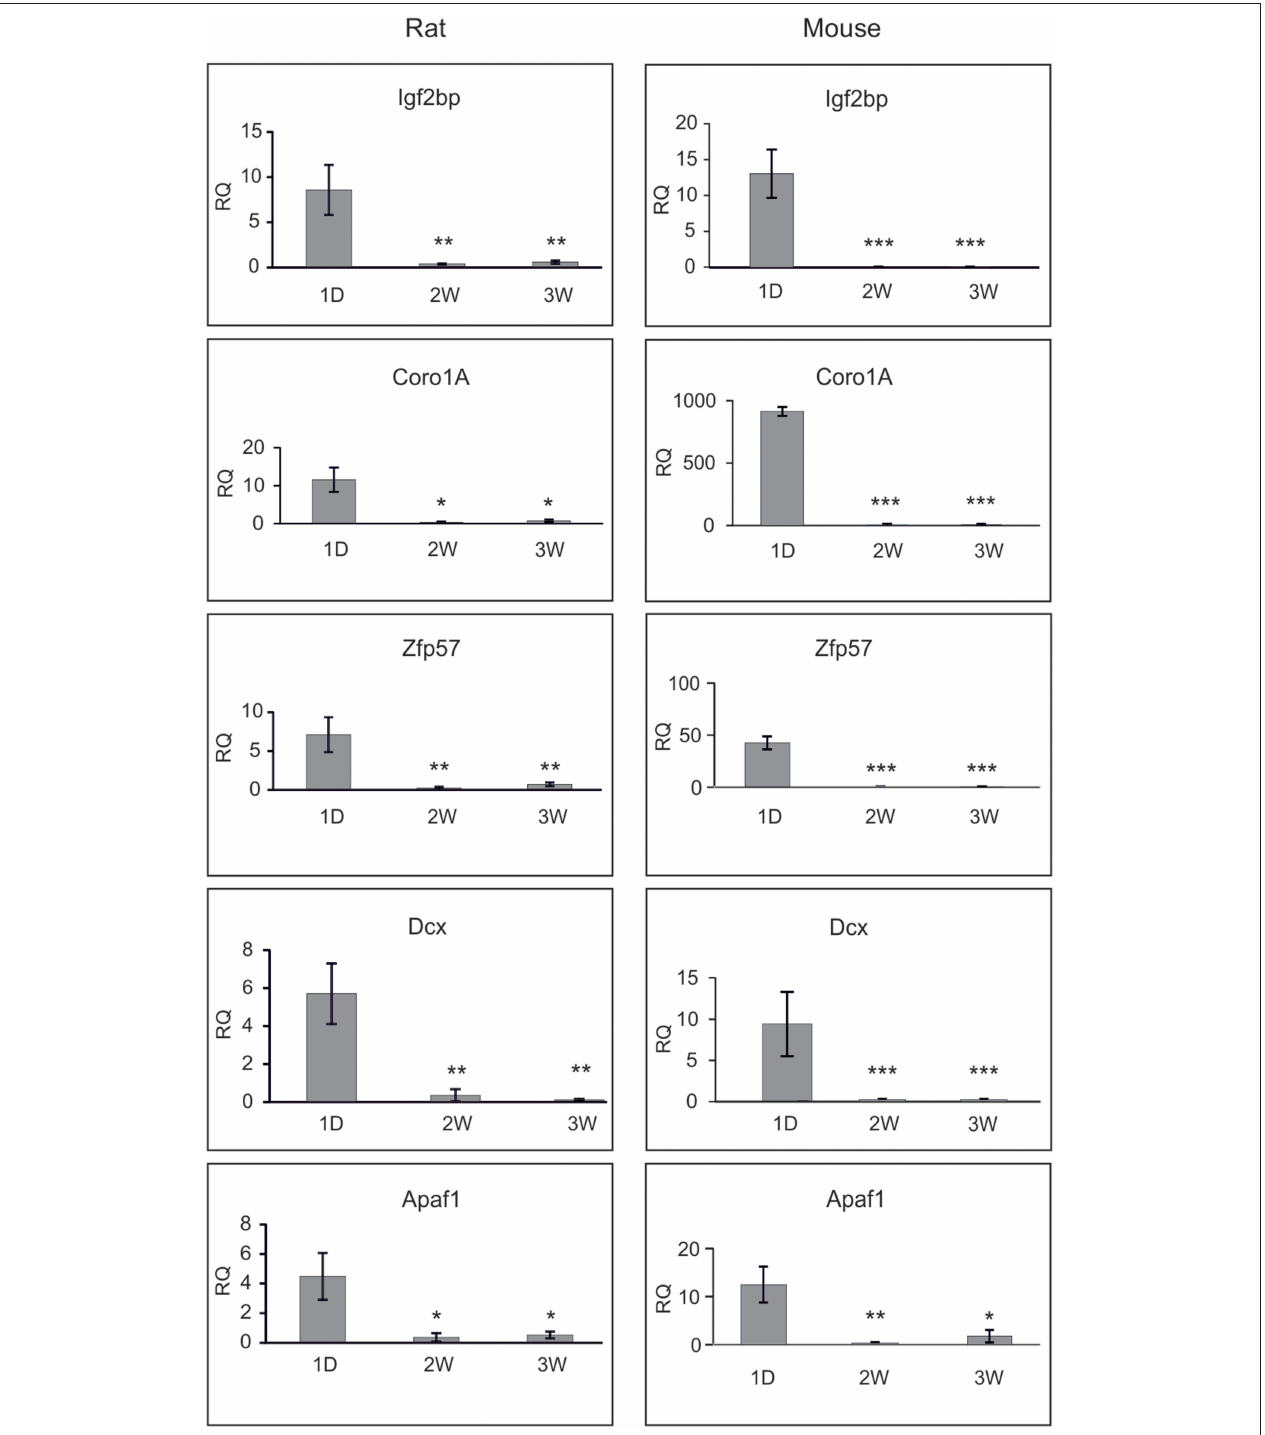
FIGURE 3 | qPCR analysis of the selected genes during maturation of rat SCG. Shown are the relative mRNA quantifies (RQ) from newborn (1D), 2 weeks (2W) and 3 weeks (3W) old rat and mouse SCG, normalized to the levels of Nefh and calibrated against the laboratory golden standard. Three independent analyses (except four for rat Apaf1 ) were performed and the means were compared with one-way ANOVA followed by Tukey-Kramer Multiple Comparisons Test. Shown are the means ± S.E.M. * p < 0.05 ; ** p > 0.01 , *** p > 0.001. The null hypothesis was rejected at p < 0.05 .